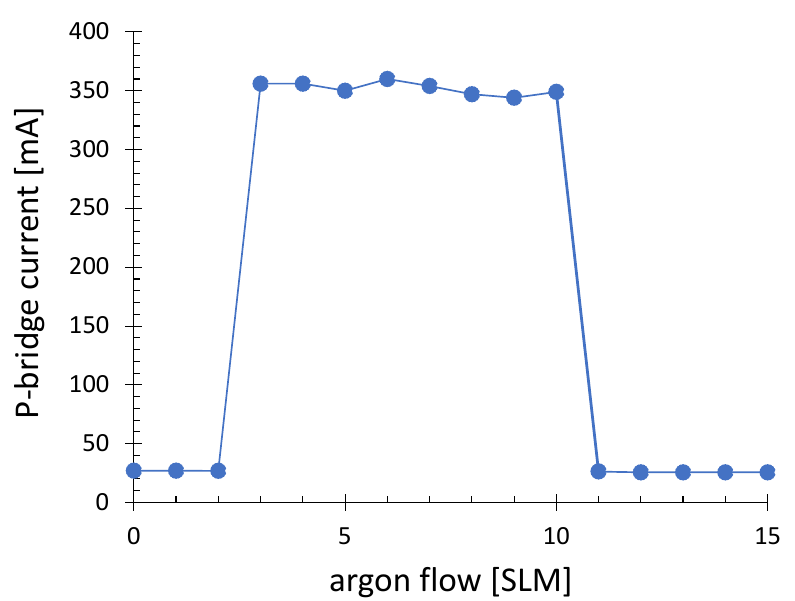
Figure 12. The plasma bridge current measured on the wire between the injector and ground as a function of the argon flow. The distance between the nozzle and substrate is 6.5 mm. The distance between the injector and substrate is 2.8 mm. The distance between the injector and the nozzle axis is 5 mm. Operation frequency is 62 kHz. Power level is 100%. FG 95/5 flow is 60